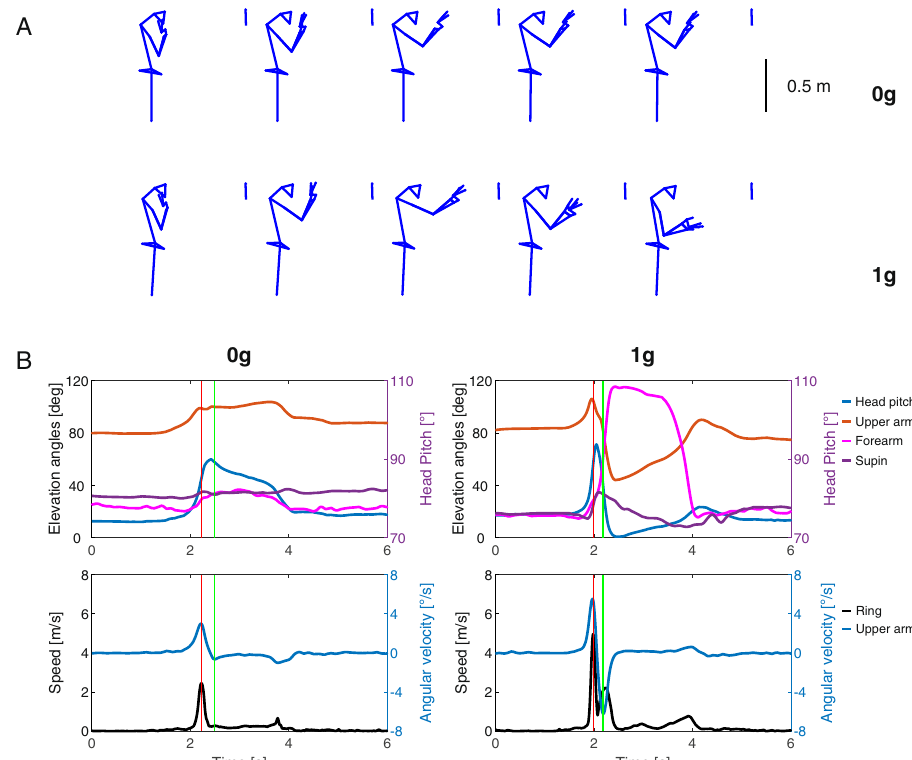
Fig. 9 Throws of the imaginary ball to a frontal target. A From left to right, stick diagrams at 100 ms before throw, throw, 100 ms after throw, catch, and 100 ms after catch. The short vertical bar on the right of each panel depicts the bullseye target. B Upper row: time course of head pitch, upper arm, forearm, and prono-supination angles. Lower row: upper arm angular velocity and ring fi nger velocity. Red and green vertical lines correspond to throw and catch times. Two representative trials of participant S12, imaginary 0 g and 1 g condition, pre- fl